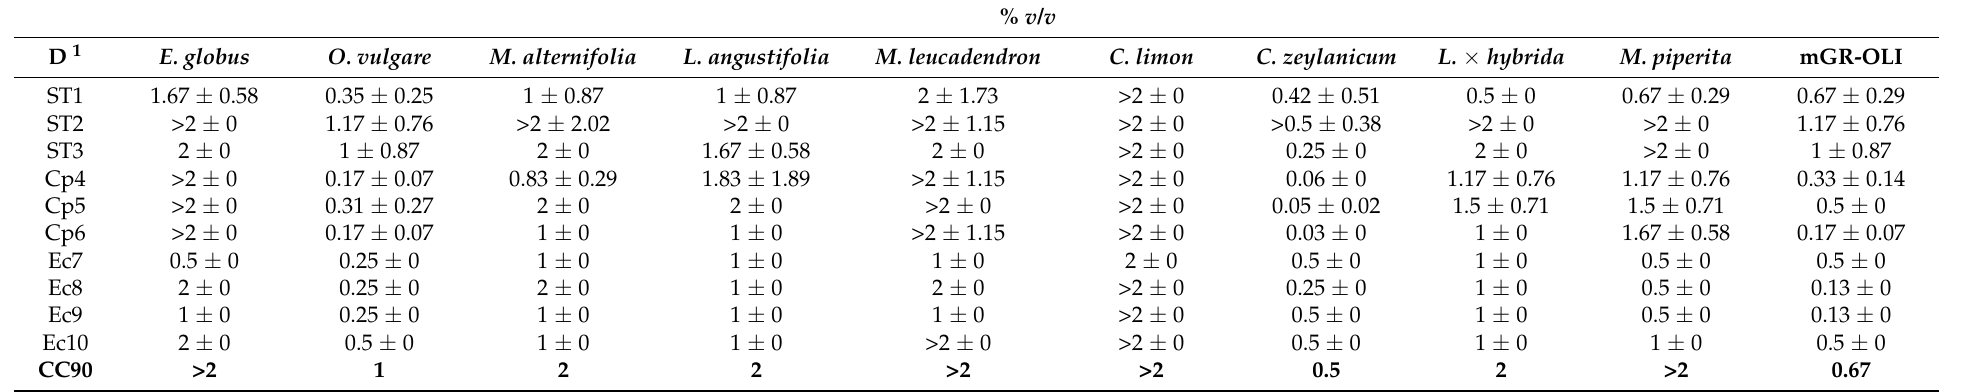
Table 5. Susceptibility testing against natural products: MBC (% v / v